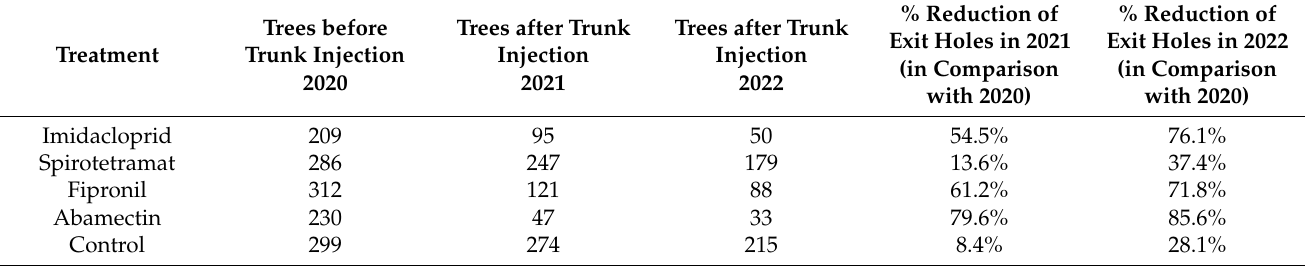
Table 1. Total number of Xylotrechus chinensis exit holes before (2020) and after the application of trunk injection (2021, 2022). Percentage of reduction of exit holes after the two-year application of trunk injection in comparison with the year before